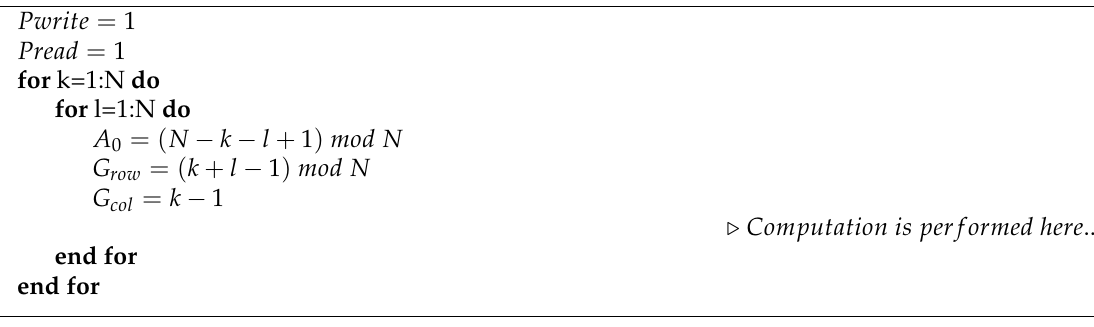
Algorithm 3 Addressing scheme for PG computation.